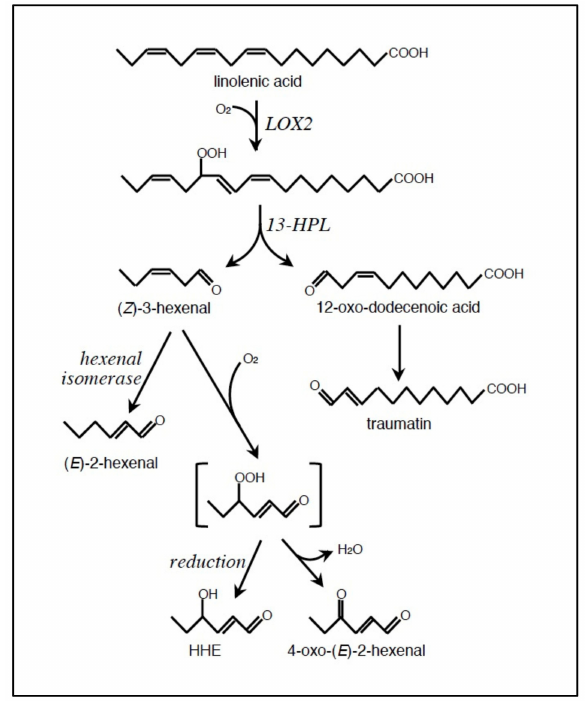
Figure 2. Enzymatic formation of RCS from linolenic acid (18:3) in A. thaliana . The oxygenation with LOX2 produces 13-hydroperoxo-octadecatrienoic acid (13-HPOTE) as shown, while with the isozyme 9-LOX, 9-HPOTE is produced. 13-HPOTE is cleaved by the 13-hydroperoxide lyase (13-HPL), while 9-HPOTE by the isozyme 9-HPL, producing C9 aldehydes. When the reaction starts with di ff erent unsaturated fatty acids such as linoleic acid (18:2), other sets of aldehydes are formed via a similar series of enzyme